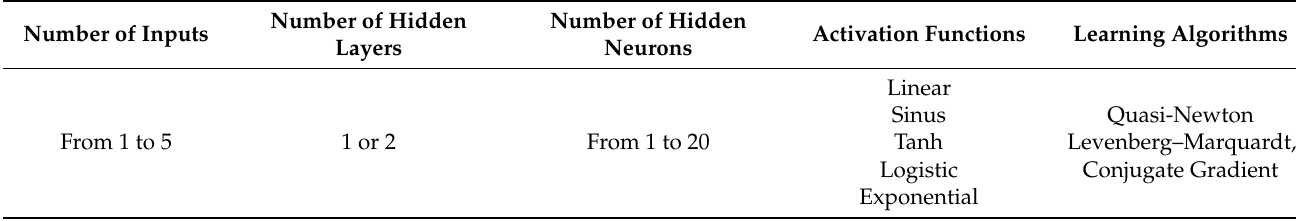
Table 2. Variants of the analyzed topologies of the artificial neural network (ANN).